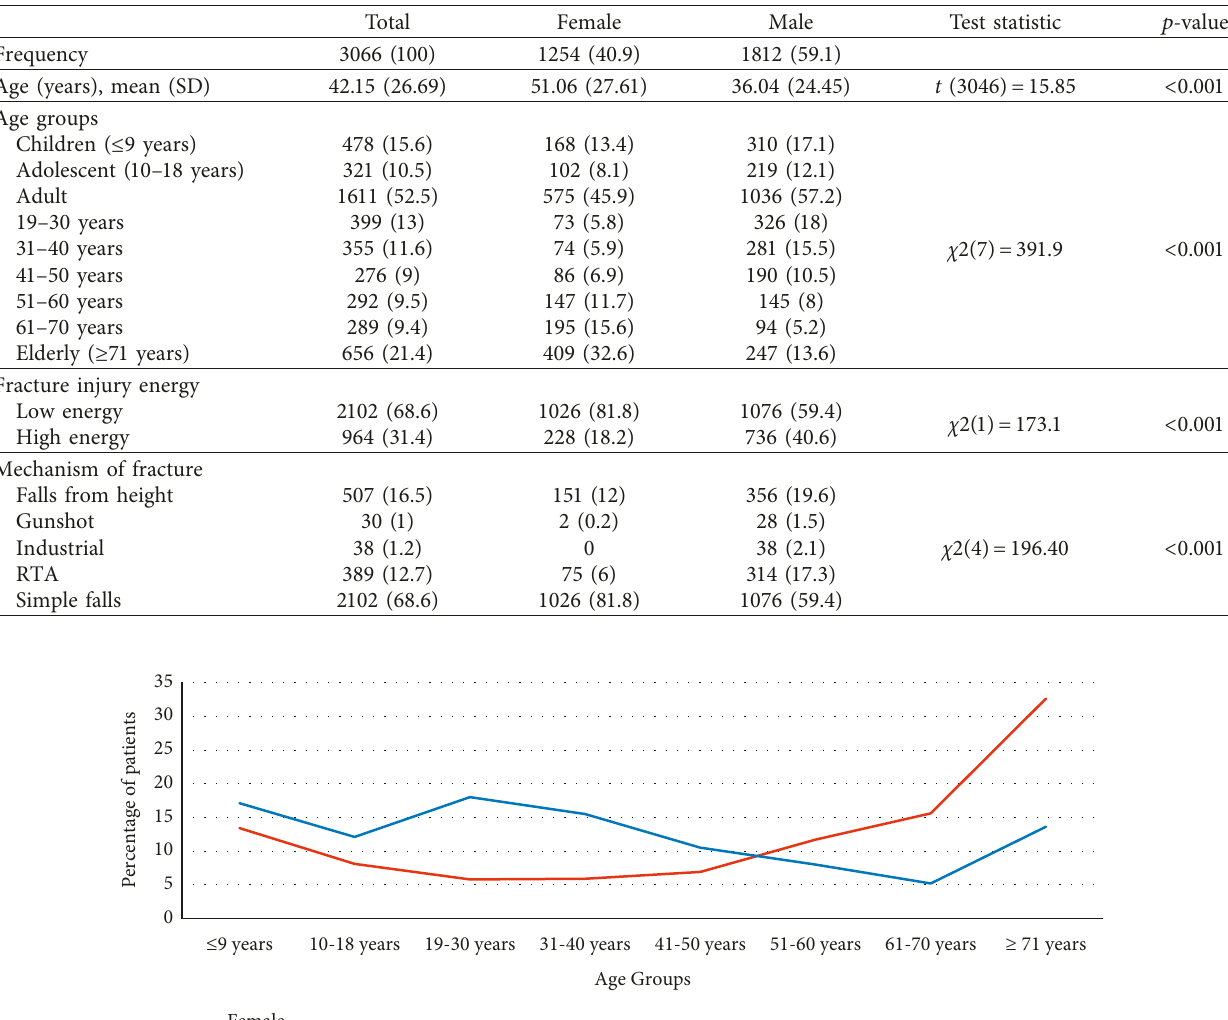
Table 1: Bivariate comparison between male and female bone injury patients, n � 3066.